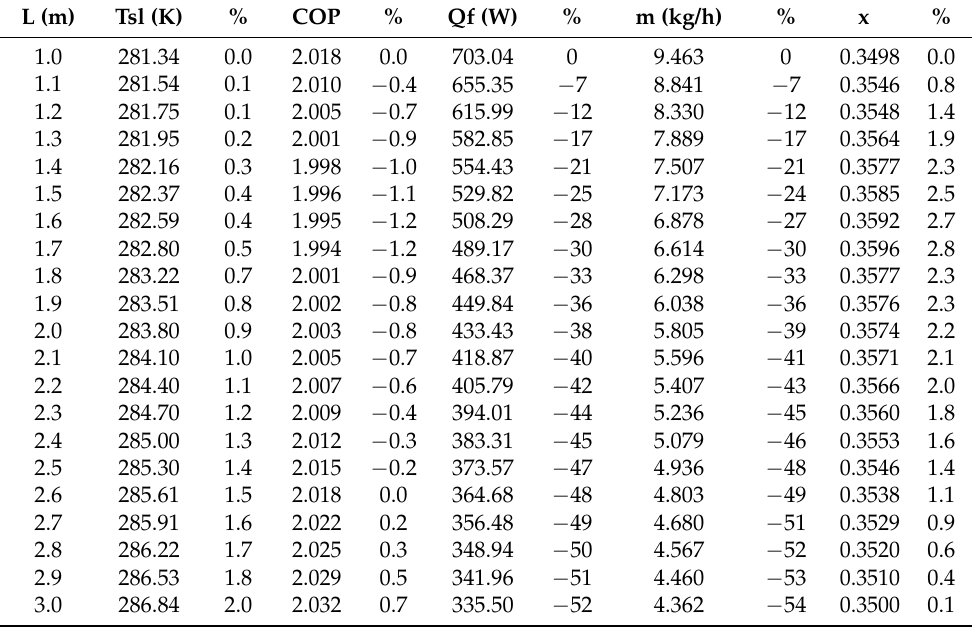
Table 3. Sensitivity analysis with respect to capillary tube length. T cond = 54 ◦ C; T evap = − 3.7 ◦